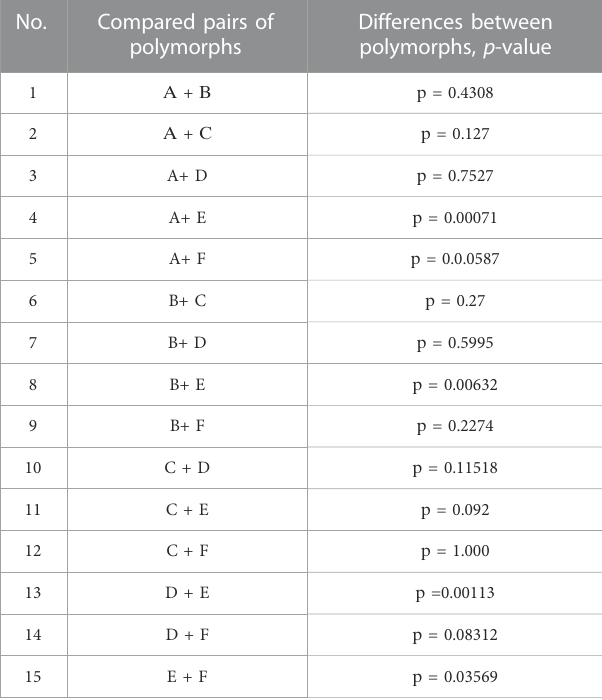
TABLE 11 Analysis of statistically signi fi cant differences between the effects of all polymorphs. No. Compared pairs of Differences between polymorphs polymorphs, p